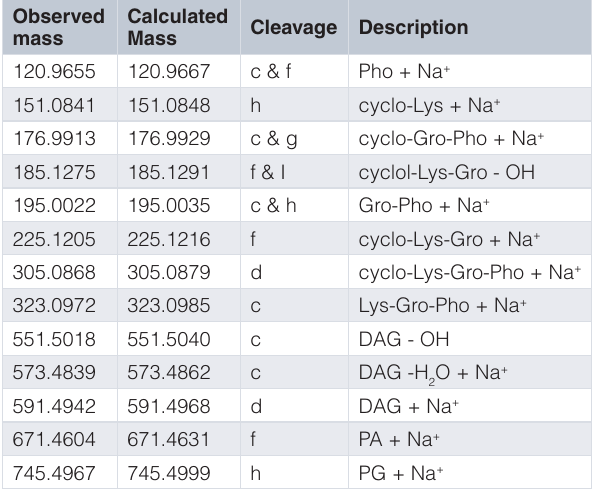
Table 1. Accurate masses of fragments from lysyl-PG. Observed mass